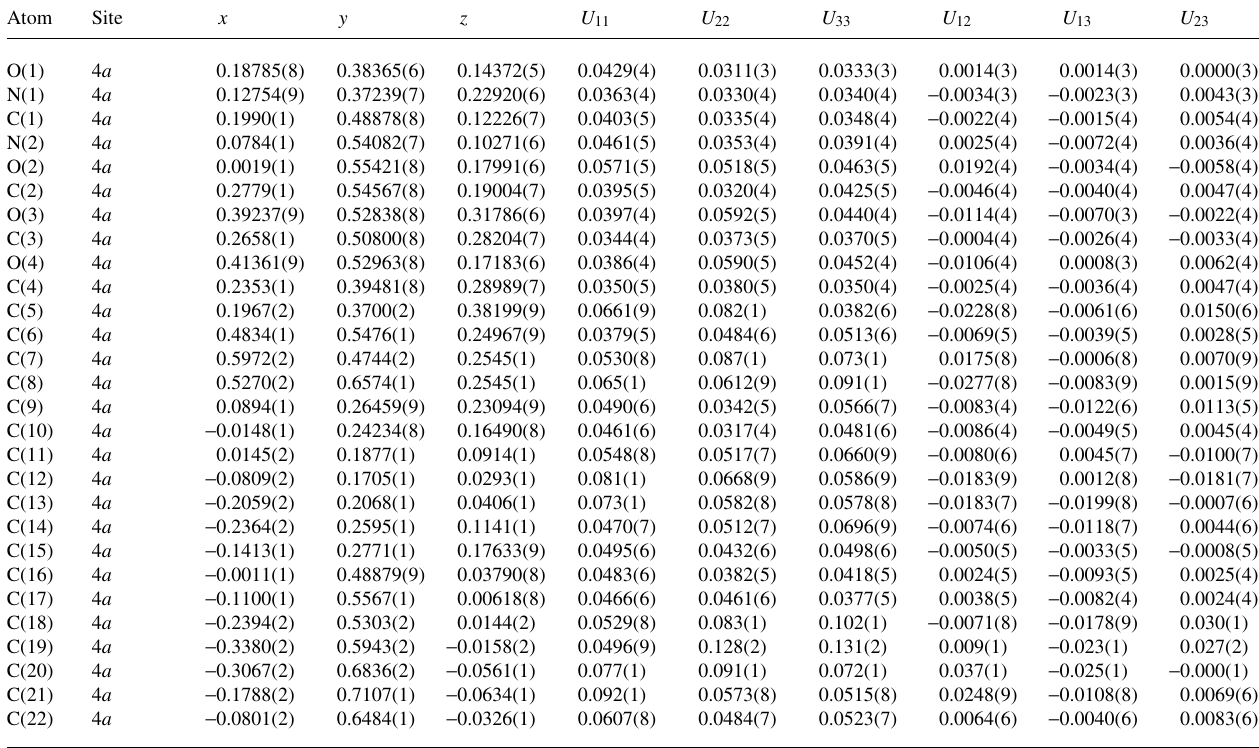
Table 3. Atomic coordinates and displacement parameters (in Å 2 ) .